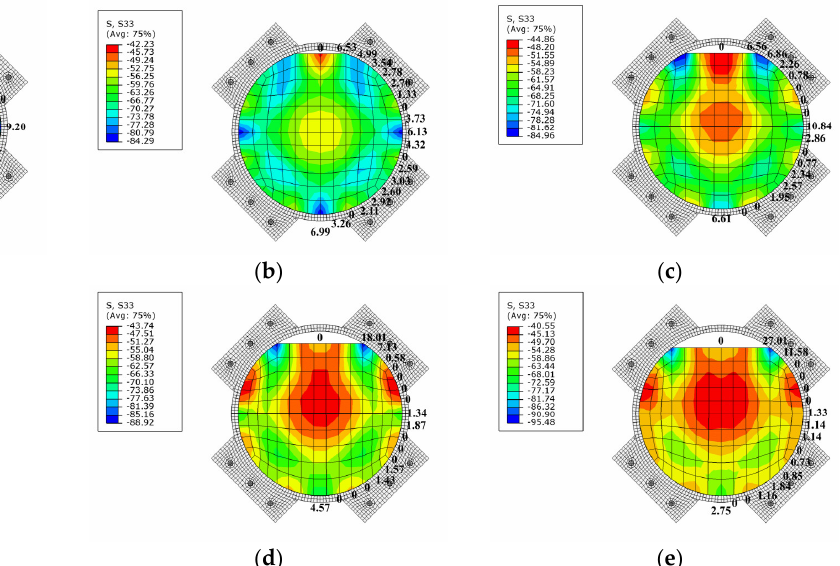
Figure 28. Distribution of S33 of core concrete and p at peak strength (in MPa): ( a )  = 0%; ( b )  = 2.3%; ( c )  = 4.6%; ( d )  = 6.9%; ( e )  = 9.2%.